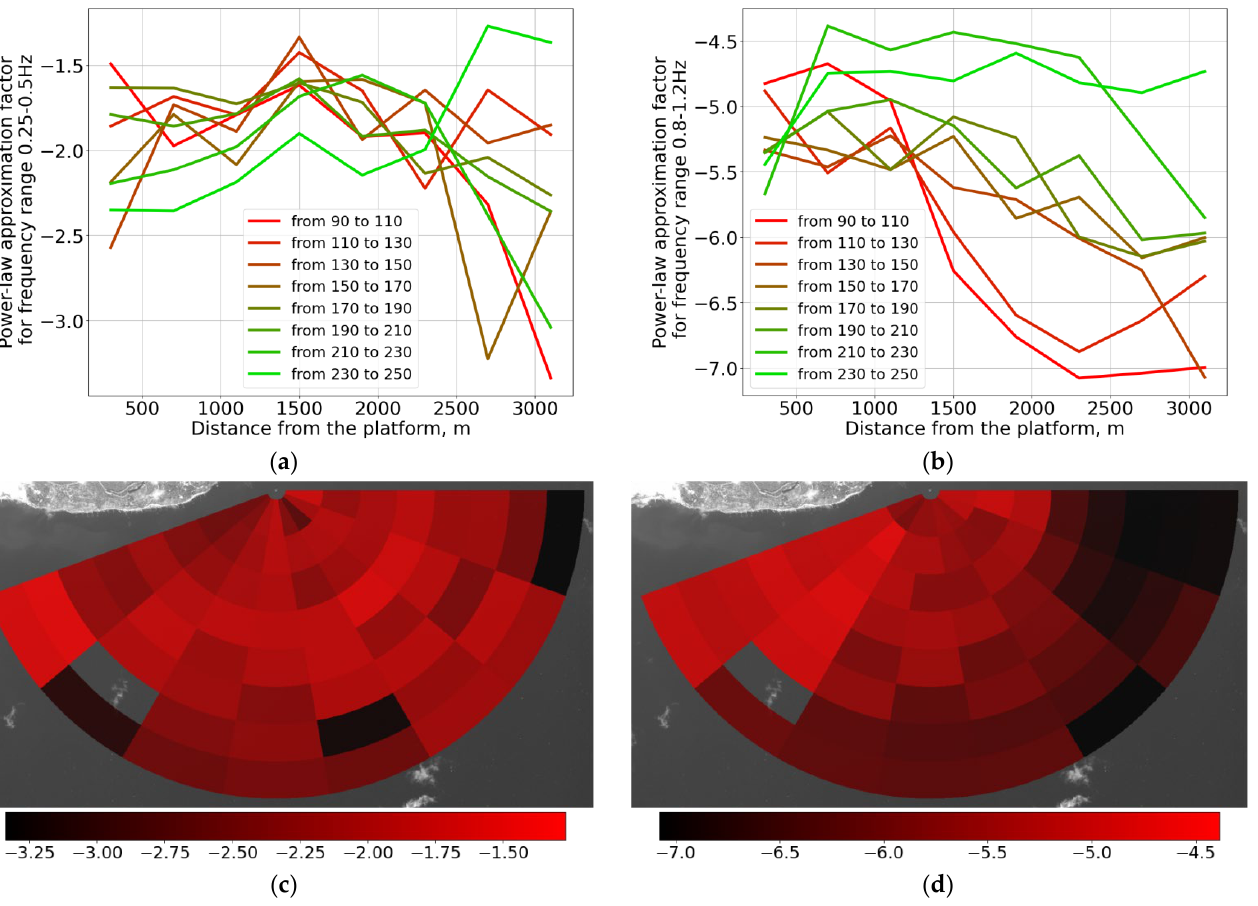
Figure 12. ( a , c ) Dependence of the exponent of power-law approximation for frequency range of